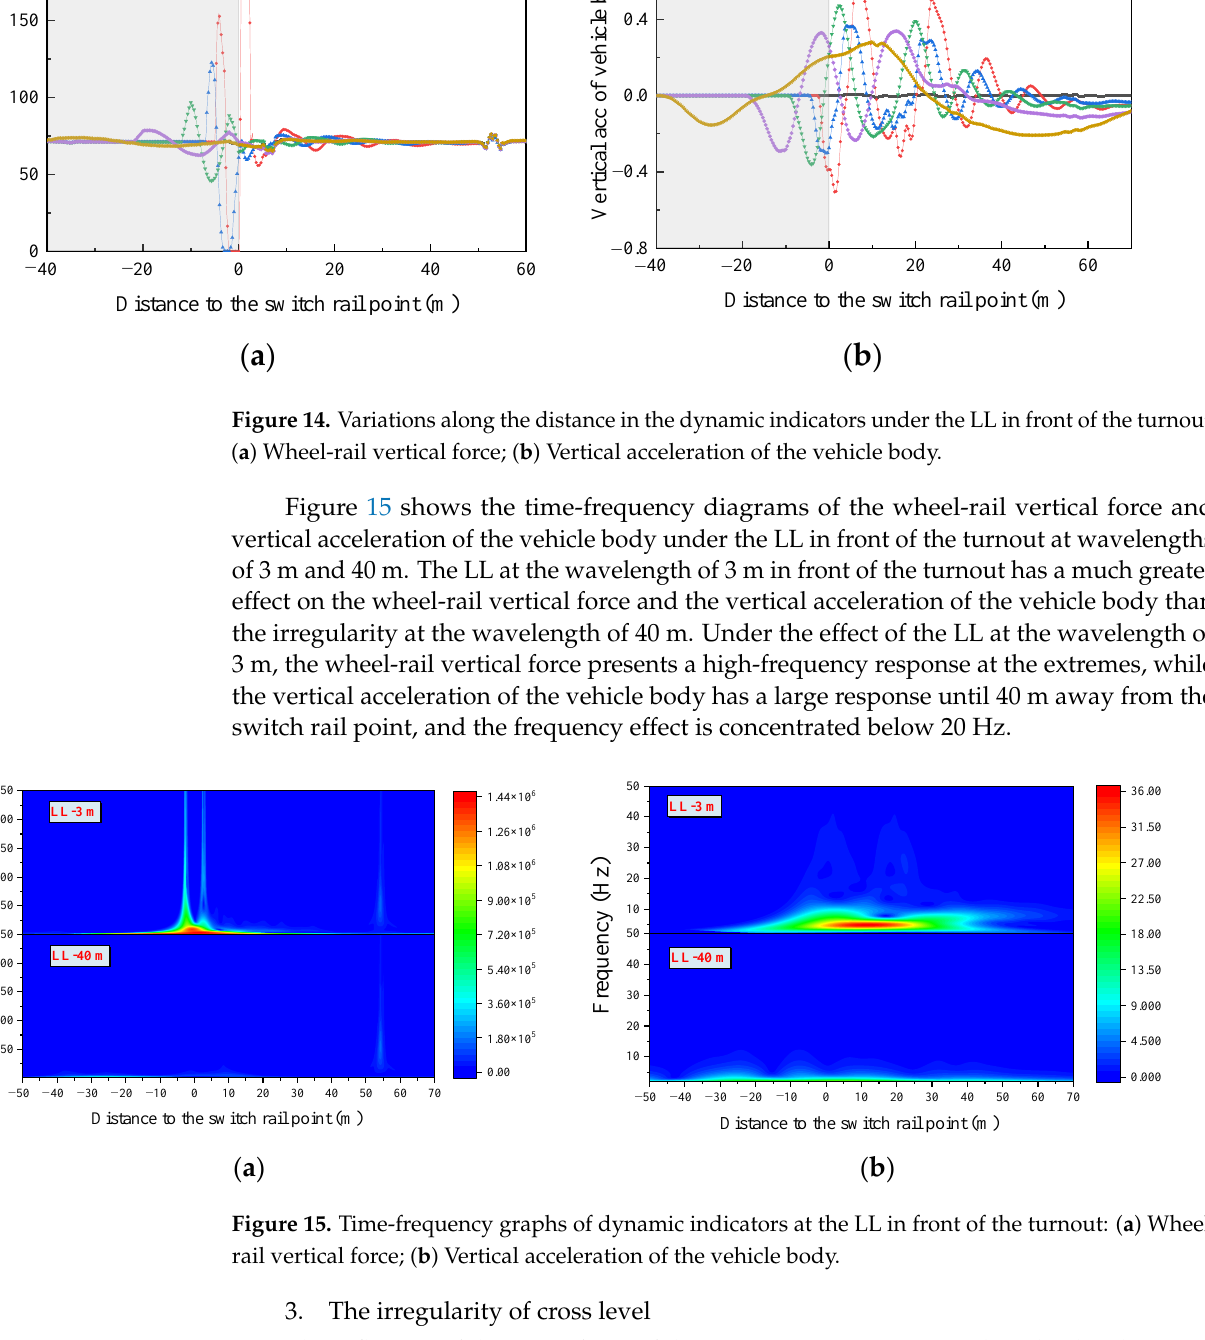
Figure 15. Time-frequency graphs of dynamic indicators at the LL in front of the turnout: ( a ) Wheel- rail vertical force; ( b ) Vertical acceleration of the vehicle body.